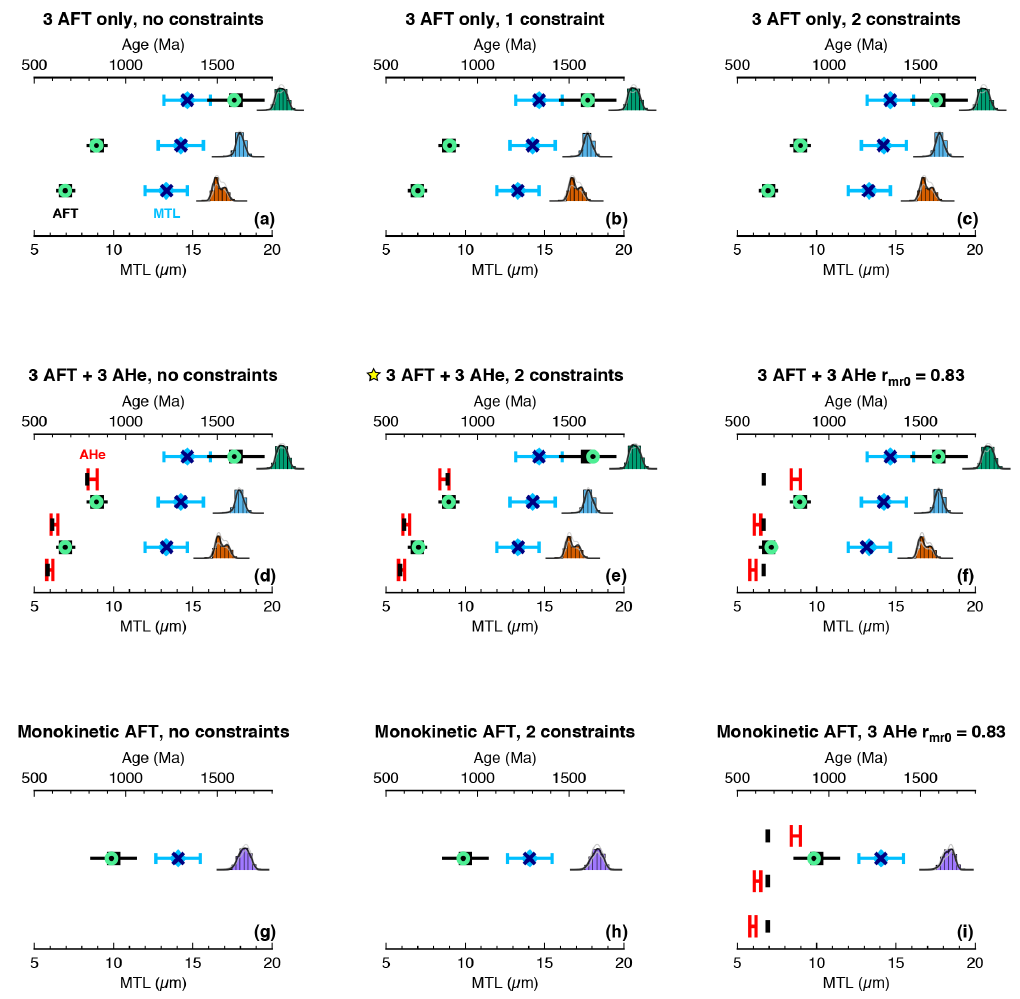
Figure 4. QTQt inversion predictions compared to “observed” synthetic thermochronology data generated during forward modelling. Panel letters correspond to counterpart t – T model panels in Fig. 3. All predictions are for the maximum likelihood models. Squares are observed AFT central age ± 2 σ , circles are predicted AFT age, diamonds are observed MTL ± 1 σ , and X symbols are the predicted MTL. Individual model fits to each track length distribution for the AFT kinetic populations are also shown and colour-coded the same as Fig. 2. Observed apatite He ages shown by red H symbol (spans the 1 σ error range quoted in the text) and predicted AHe ages are black bars. Panel (e) with star is our best model that accounts for all multikinetic AFT populations and utilizes the true AHe kinetics and two geologic constraints, all combined for the highest thermal-history resolution. Note that track length distributions are arbitrarily placed next to their respective age population and were not plotted with respect to the MTL plot